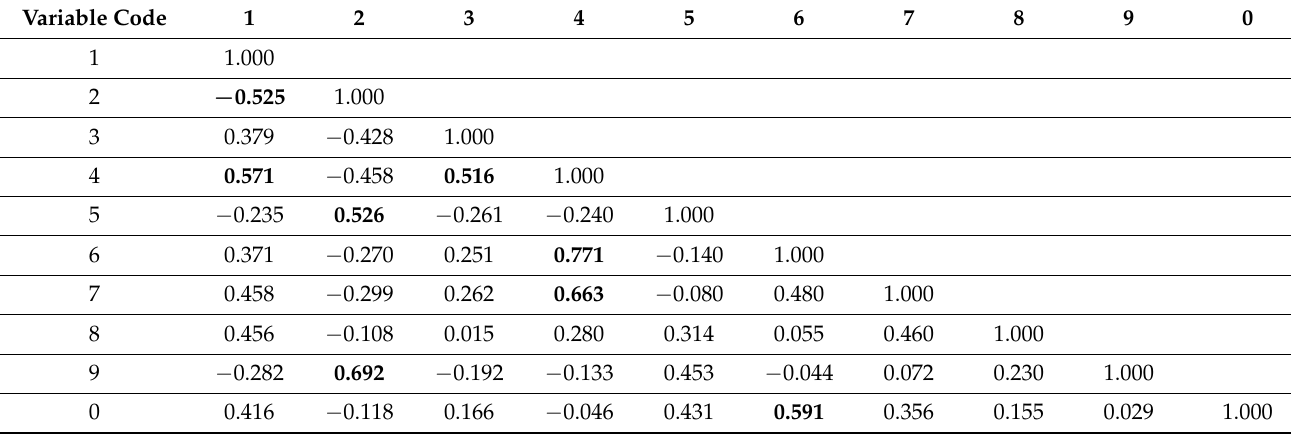
Table A3. Correlations matrix (values in bold represent high correlation between